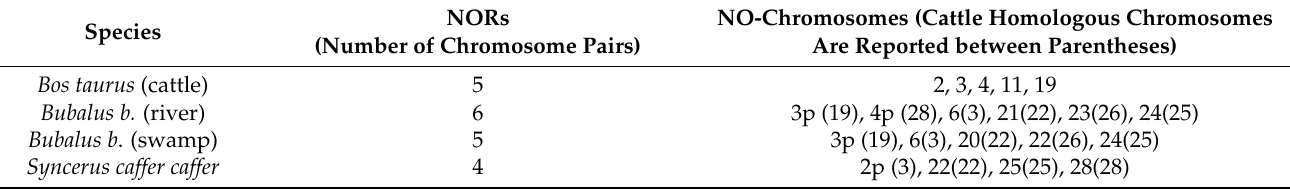
Table 2. Number of nucleolus organizer regions (NORs) and nucleolus organizer (NO) chromosomes in cattle and buffaloes. Homologous cattle NO chromosomes in buffaloes are reported between parentheses according to [52,65,87]. NORs NO-Chromosomes (Cattle Homologous Chromosomes Species (Number of Chromosome Pairs) Are Reported between Parentheses) Bos taurus (cattle) 5 2, 3, 4, 11, 19 Bubalus b. (river) Bubalus b . (swamp) Syncerus caffer